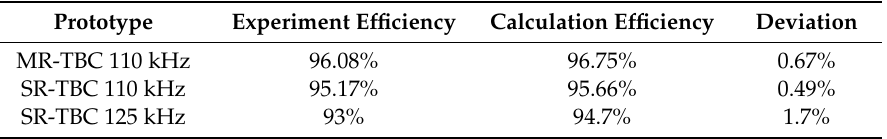
Table 3. Efficiency comparison between MR-TBC and SR-TBC in 1000 W. Prototype